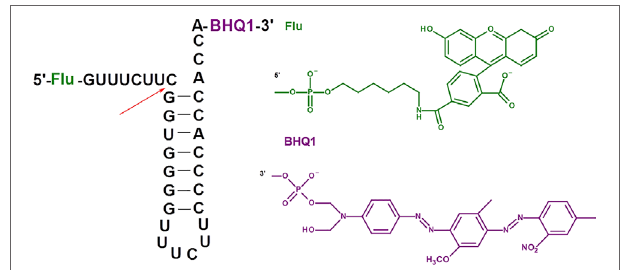
FIGURE 3 | The influence of inhibiting oligoribonucleotide r-inh on hydrolysis of fluorescent RNA target. The cleavage conditions: 5 nM M1 RNA, 50 nM